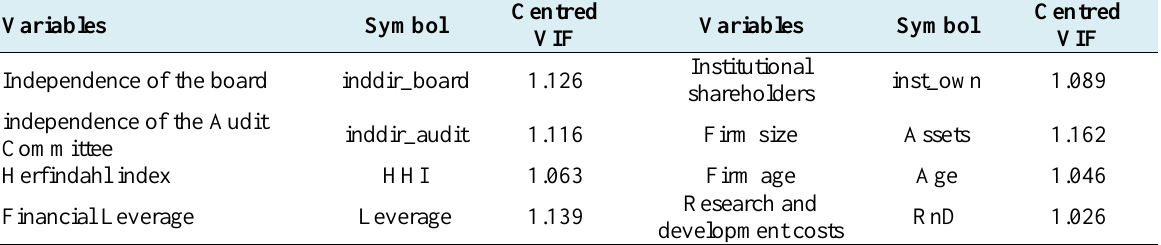
Table 3. VIF test results for explanatory variables used in research regression models